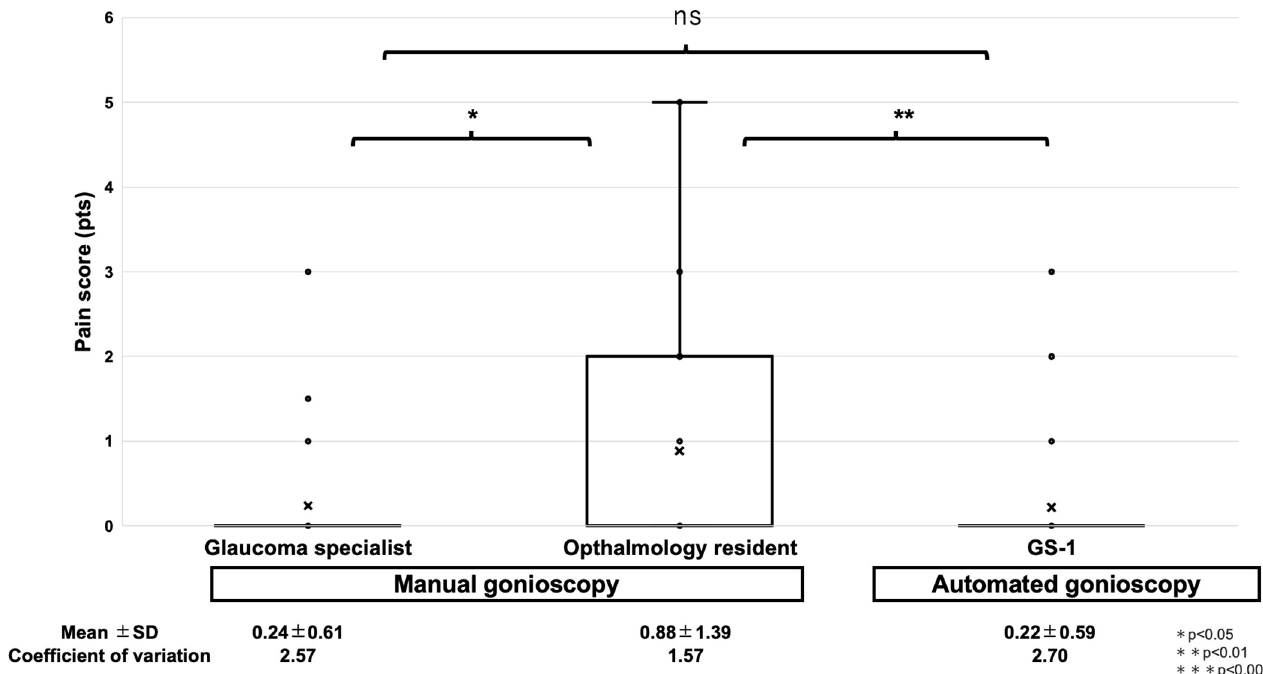
Fig 4. Comparison of the pain scores during examinations between the glaucoma specialist, ophthalmology resident, and automated gonioscopy. * , ** , and *** represent p < 0.05, < 0.01, and < 0.001, respectively. ns represents statistically not significant.